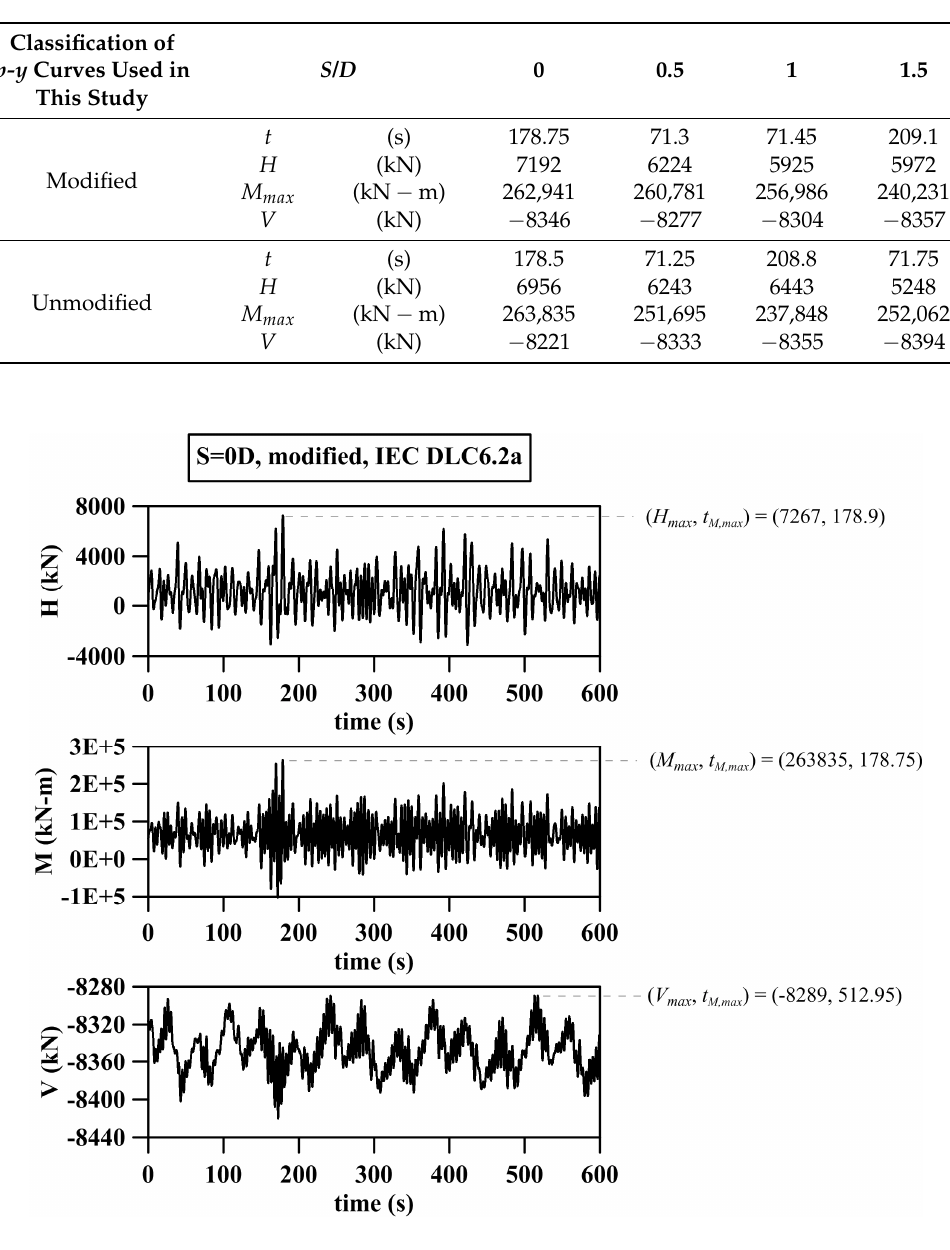
Figure 10. Loading time-series at pile head before scour occurred; ( H, M max , V ) t =178.75s = (7192 kN, 263,835 kN-m, − 8346 kN).